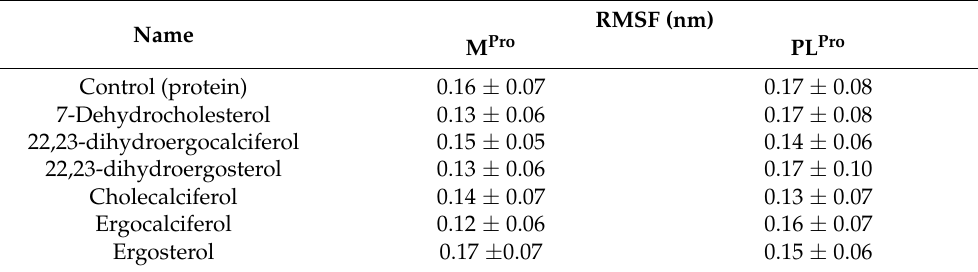
Table 3. Root mean square fluctuations (RMSF) from the initial structures of the main protease and main protease-ligand complexes and papain-like protease and papain-like protease-ligand complexes.